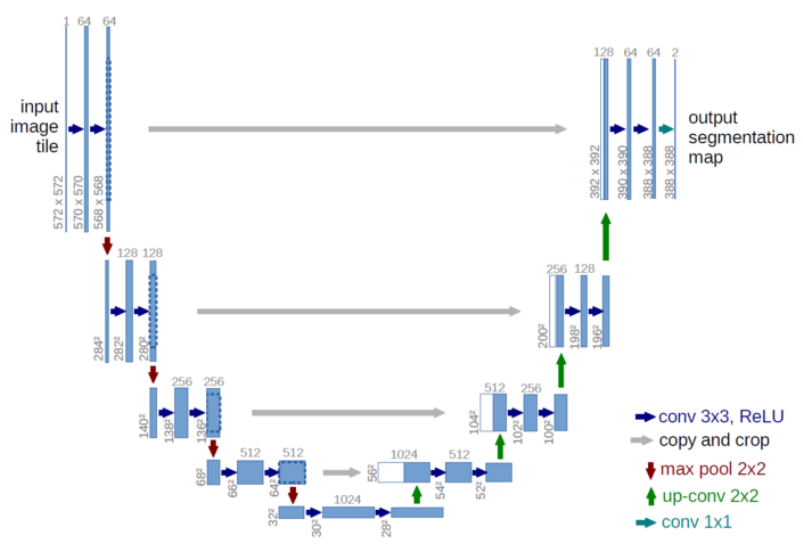
Figure 1. The U-net diagram shows a multi-channel feature map with a blue box indicating the num- ber of channels, and its lower left edge indicating the x-y-size. Copied feature maps are represented by the white boxes